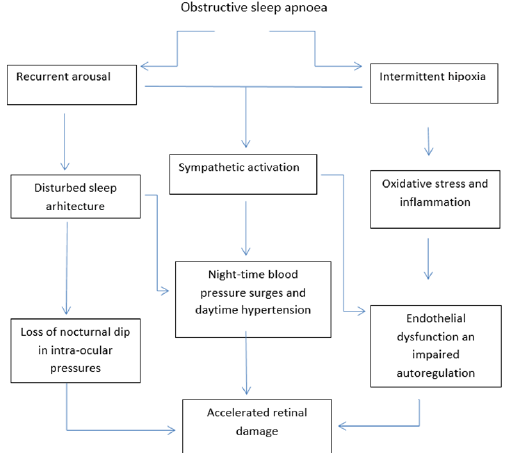
Figure 1. Mechanisms involved in SAS that cause eye damage . 3.3. Floppy Eyelid Syndrome It is the syndrome in which the upper eyelids are easily reversed at upward traction, leading to events related to the exposure of the ocular surface. In literature, the emergence of FES in patients with SAS (incidence from 2 to 40%) varies considerably. The study conducted by Karaca et al. in 2019 established a prevalence of 22.2% in patients with severe SAS [16]. A prospective study with 127 patients found that 25.8% of the patients with SAS also had FES, and this percentage continues with up to 40% in patients diagnosed with severe SAS [7]. Regarding the mechanism of SAS, and not the histology in the eyelid, in addition to chronic inflammation present without atrophy in the tissue, it was noted that at that level, there is a transient ischemic attack, which is highlighted by the hypoxia present during the recurrent episodes of apnea specific to SAS.